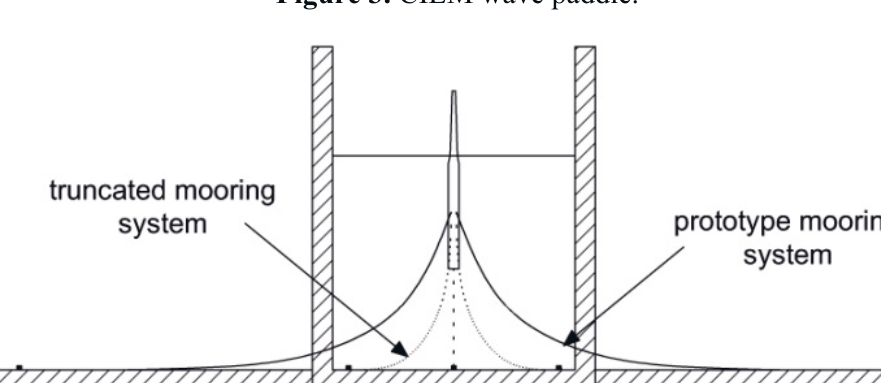
Figure 3. CIEM wave paddle.